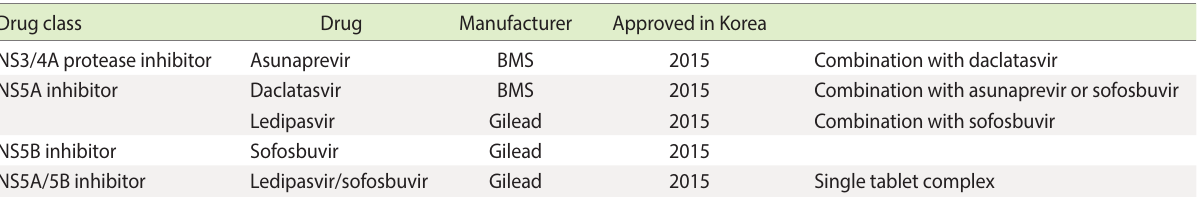
Table 2. Direct acting antiviral drugs against hepatitis C virus infection currently approved in Korea Drug class